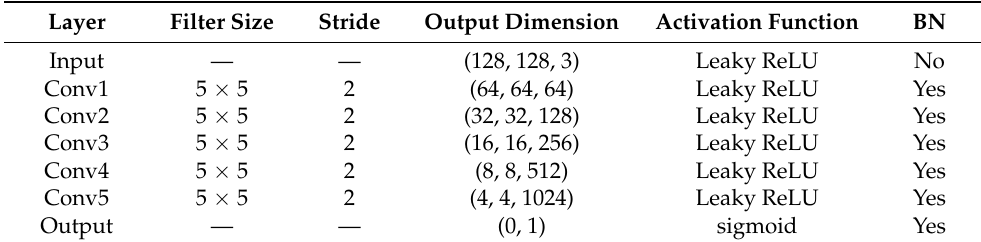
Table 5. The detailed information of the discriminant model.